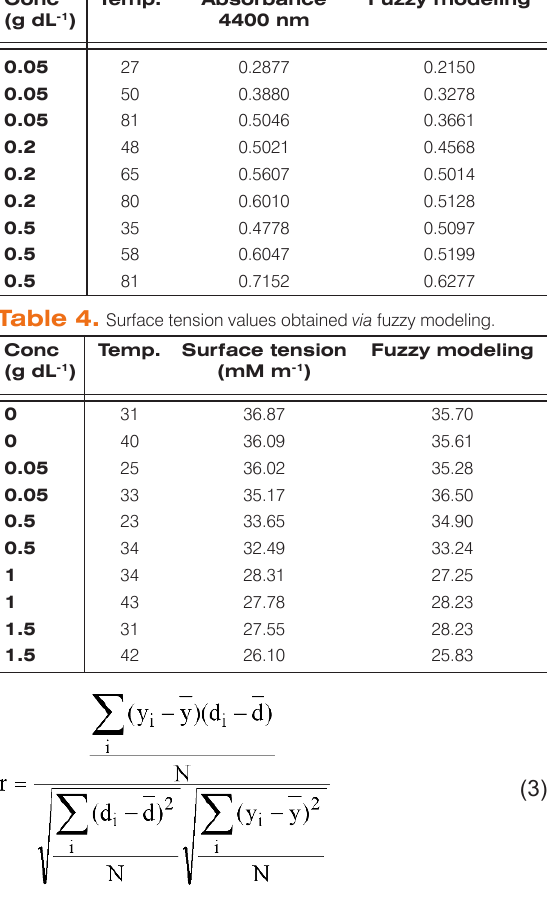
Table 3. Absorbance values obtained via fuzzy modeling. Conc Temp. (g dL -1 )